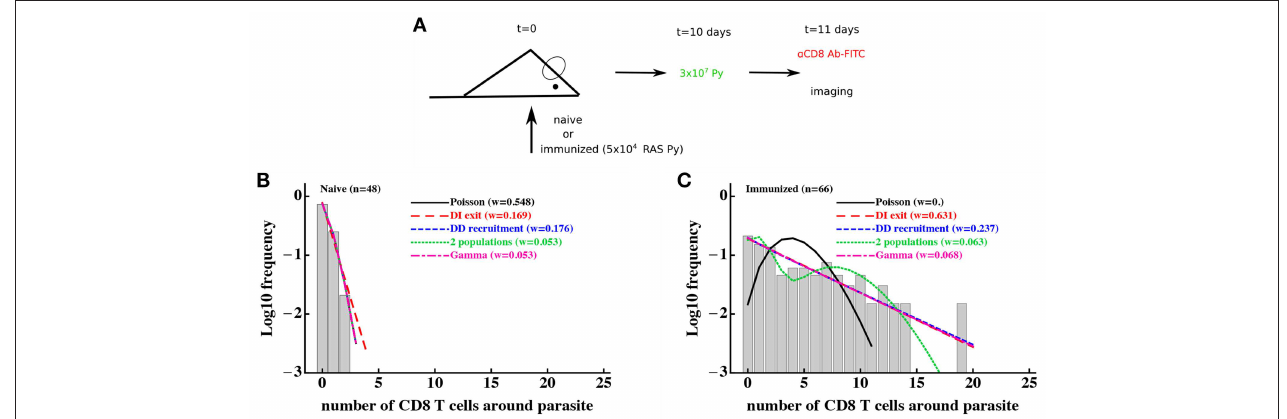
FIGURE 3 | Models assuming time-invariant but spatially-variable environment are consistent with the data on clustering of CD8 T cells in mice immunized with radiation-attenuated sporozoites (RAS). (A) Mice were immunized with 5 10 4 Py RAS or left unimmunized. Ten days later, mice were infected with 3 10 7 wild-type × × Py, expressing GFP. One day later CD8 T cells were labeled with 4 µ g PE-conjugated anti-CD8 mAbs and clustering of CD8 T cells around Py-infected hepatocytes in the liver was imaged using intravital microscopy (29). In total 48 (in naive mice, B ) and 66 (in RAS-immunized mice, C ) parasites were randomly chosen and the number of T cells in a 40 µ m radius were counted. Five different mathematical models were fitted independently to the data on T cell clustering in naive and immunized mice, and the quality of the model fits was evaluated using Akaike weights ( w ). Clustering in naive mice is most consistent with the Poisson (random entry/exit) model, while in RAS-immunized mice models assuming constant environment (“2 populations,” “gamma,” or random birth/death models) fit the data worse than other models, in part due to a larger number of parameters than in the DD recruitment or DI exit models. Parameter estimates of the best fit model and 95% CIs in panel B are θ 0 0.29 (0.17 0.42) (Poisson model) and in (C) are θ 0 0.81 (0.77 0.84) (DI exit model) or θ 0 0.80 (0.52 1.16) and θ 1 0.82 (0.73 0.88) = − = − = − = − k (DD recruitment model). According to the DD recruitment model, the average cluster size in RAS-immunized mice at steady state (B) is h i ∗ ≈